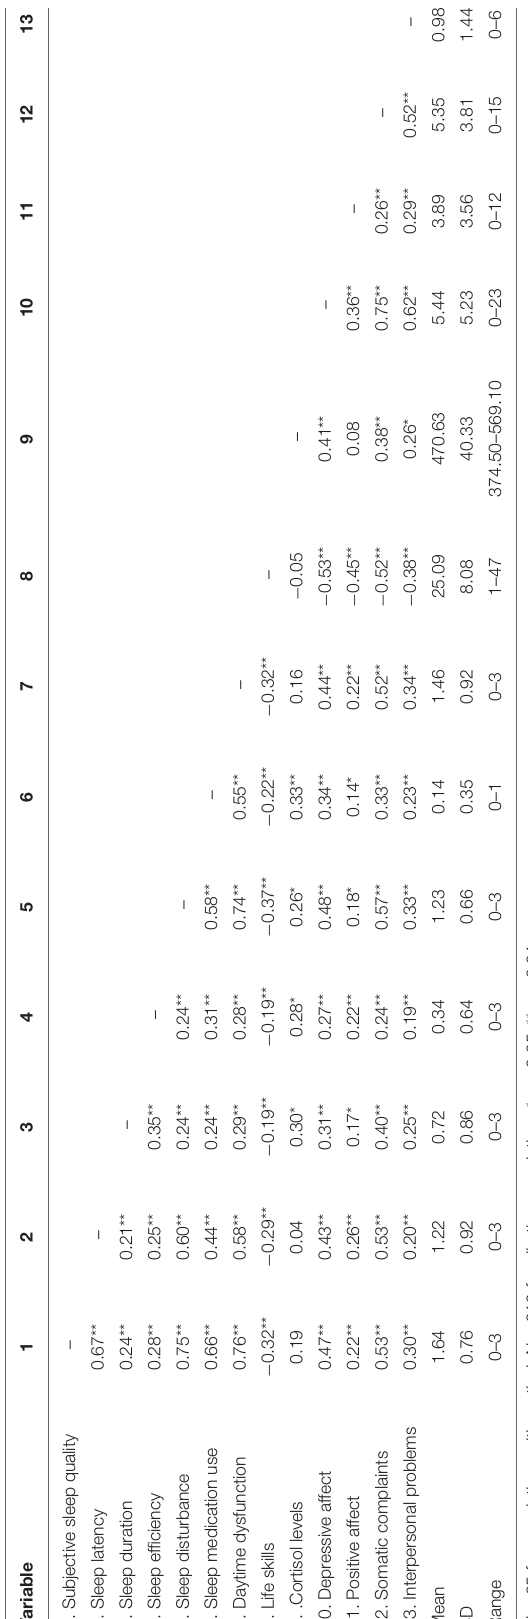
There were significant correlations among sleep quality, life skills, and depressive symptoms, as shown in Table 2 . Positive correlations between all dimensions of sleep quality (variables 1–7) and depressive symptoms (variables 10–13) were identified ( r ’s = 0.14–0.76, p < 0.05). However, life skills (variable 8) were negatively related to all dimensions of depressive symptoms (variables 10–13) ( r ’s = − 0.53 to − 0.38, p < 0.01), as well as all dimensions of sleep quality (variables 1–7; r ’s = − 0.32 to − 0.19, related to some dimensions of sleep quality (variables 3 − 6)